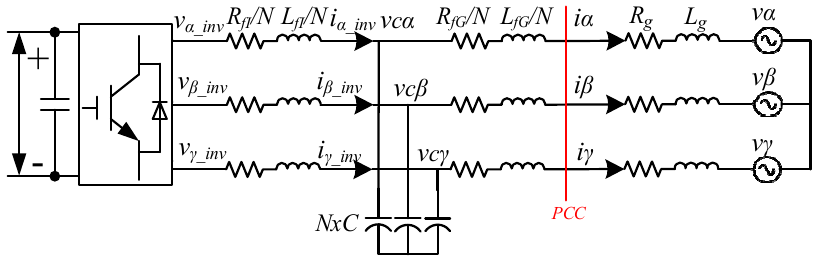
Figure 6. Equivalent circuit diagram of an IBR plant looking from the grid side.